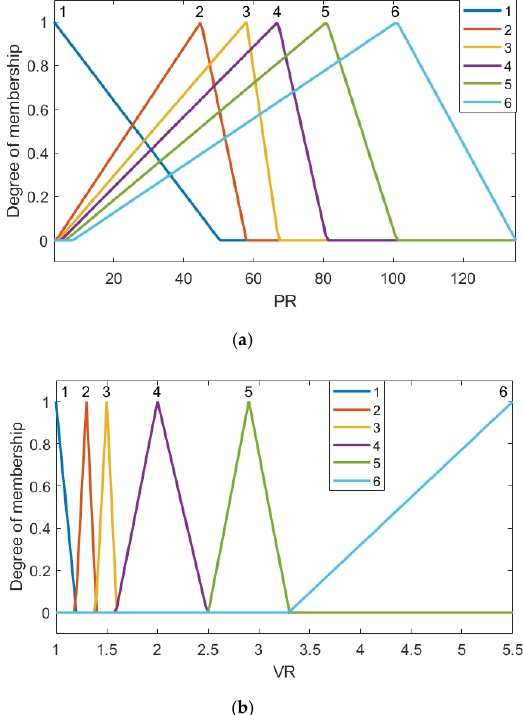
Figure 10. Membership functions of the moderate fault model: ( a ) power rate, ( b ) voltage rate.